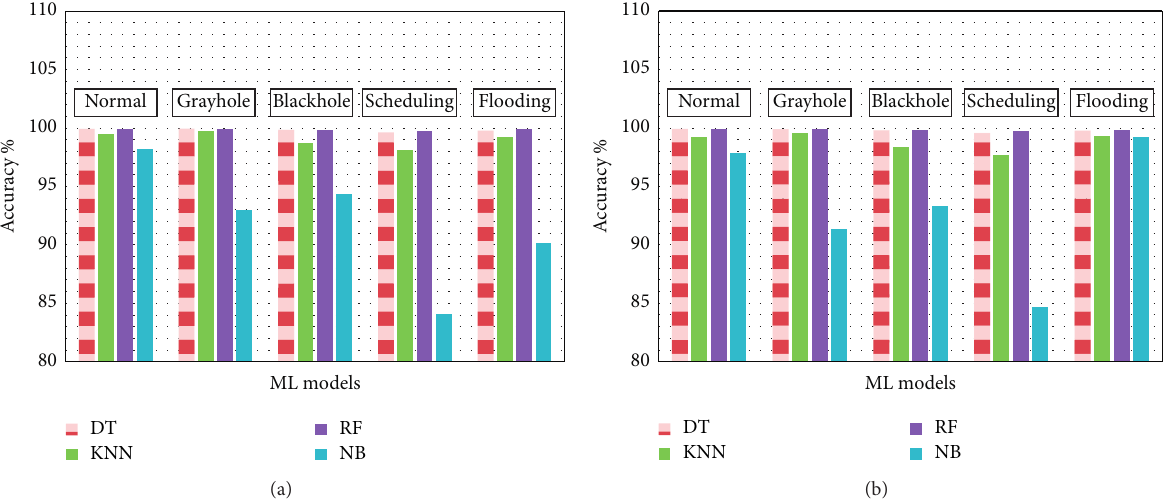
Figure 4: The results of machine learning testing performance for WSN dataset: (a) accuracy using all features and (b) accuracy using selected features.